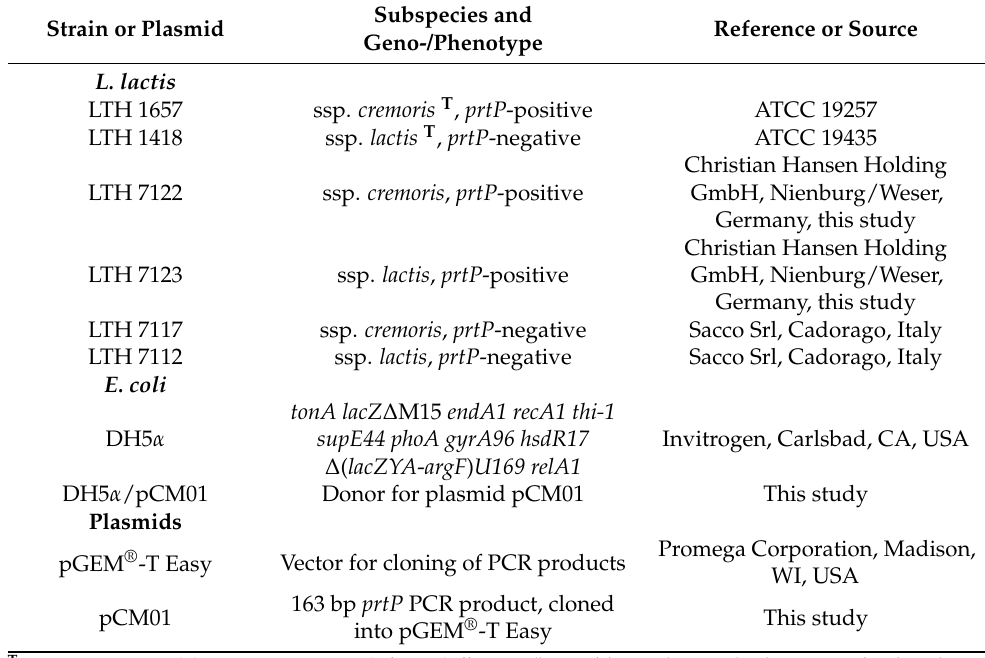
Table 1. Strains and plasmids used in this